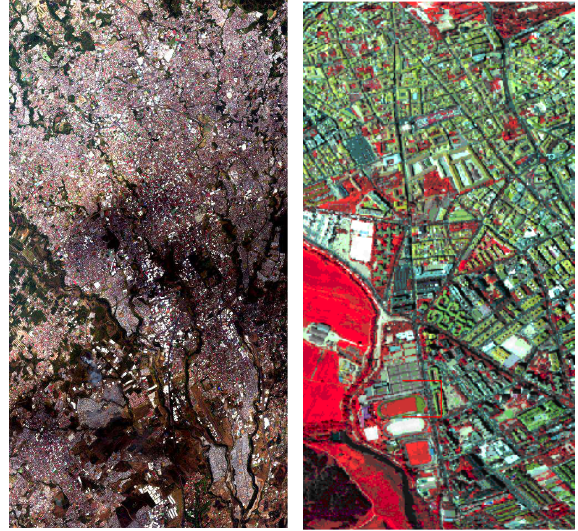
Figure 1 . AHS rgb 12,6,2 combination image of Alcalá de Henares (right) and MASTER rgb 13,7,4 combination of San José (left).